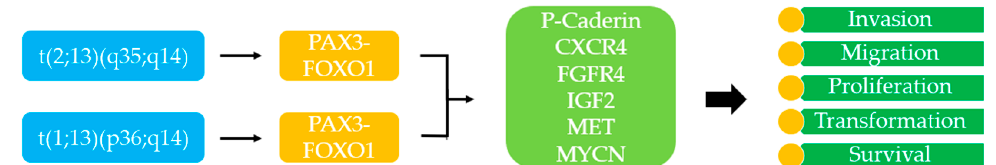
Figure 2. The fusion protein PAX3/7-FOXO1 is a transcriptional factor that is supposed to have a role in stopping skeletal muscle differentiation and facilitating aberrant cell division, resulting in tumor development. In the figure, some transcriptional targets of PAX3/7-FOXO1 are shown, which have a role in migration, proliferation, transformation, and survival of tumoral cells in RMS.